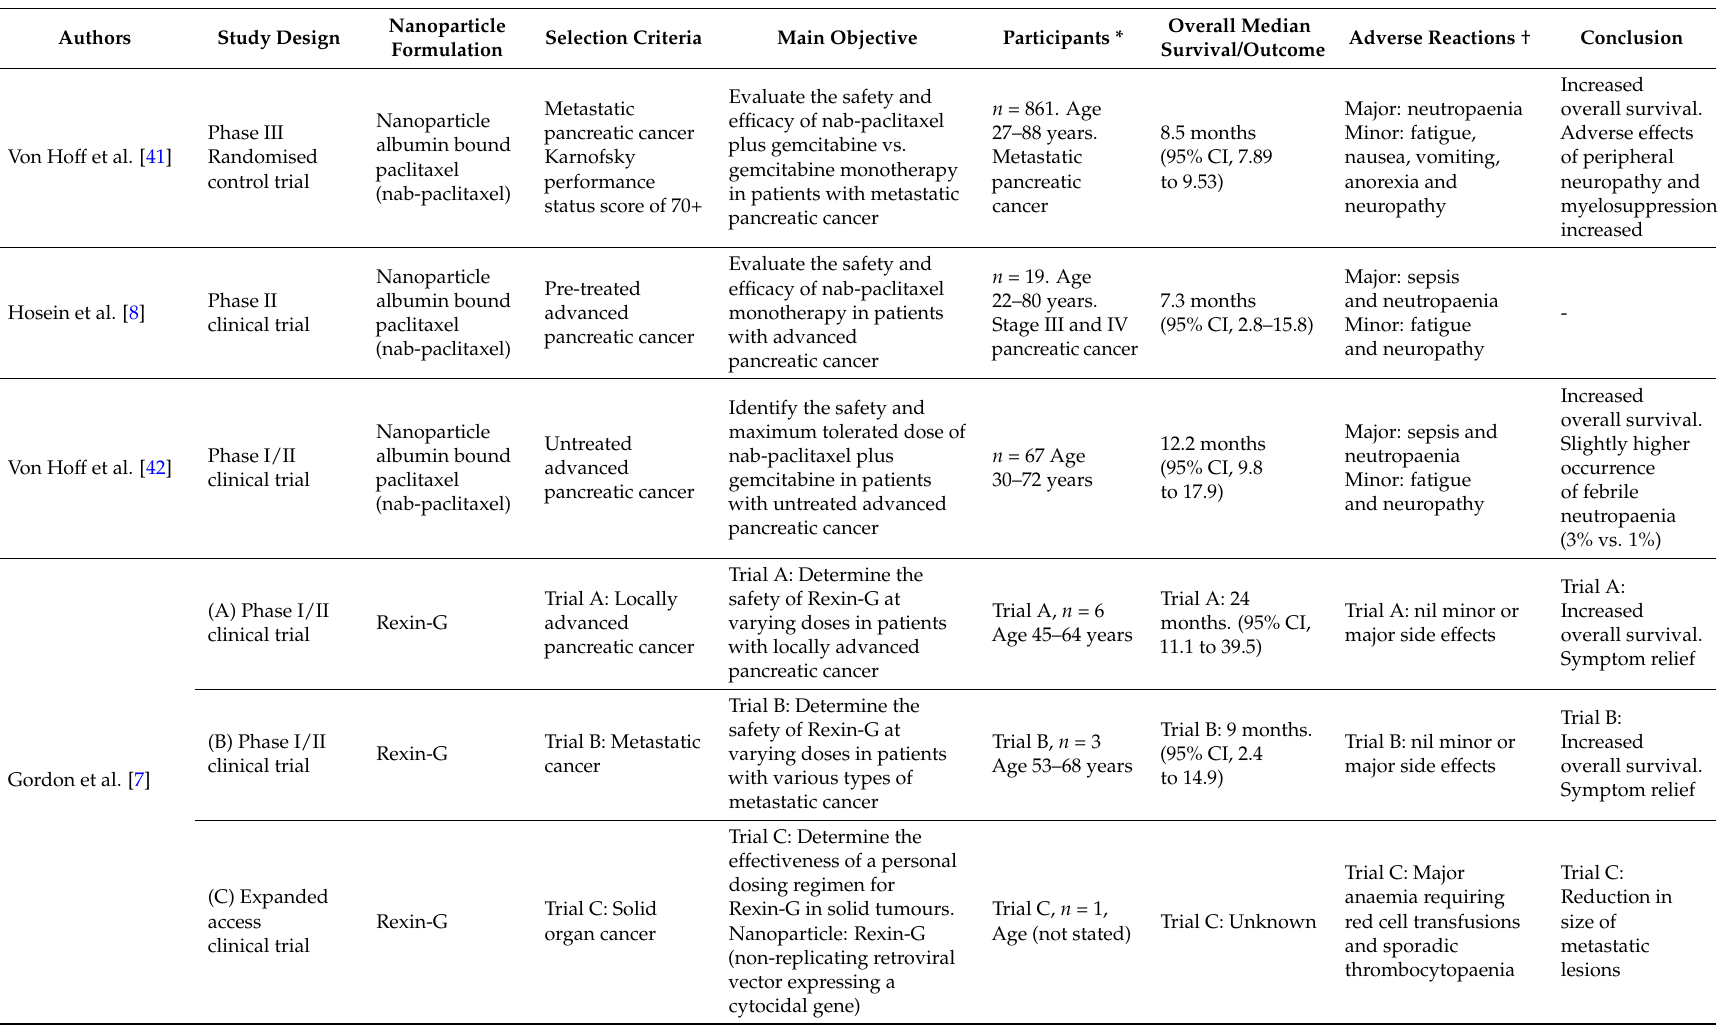
Table 2. Summary of findings associating nanoparticles with pancreatic